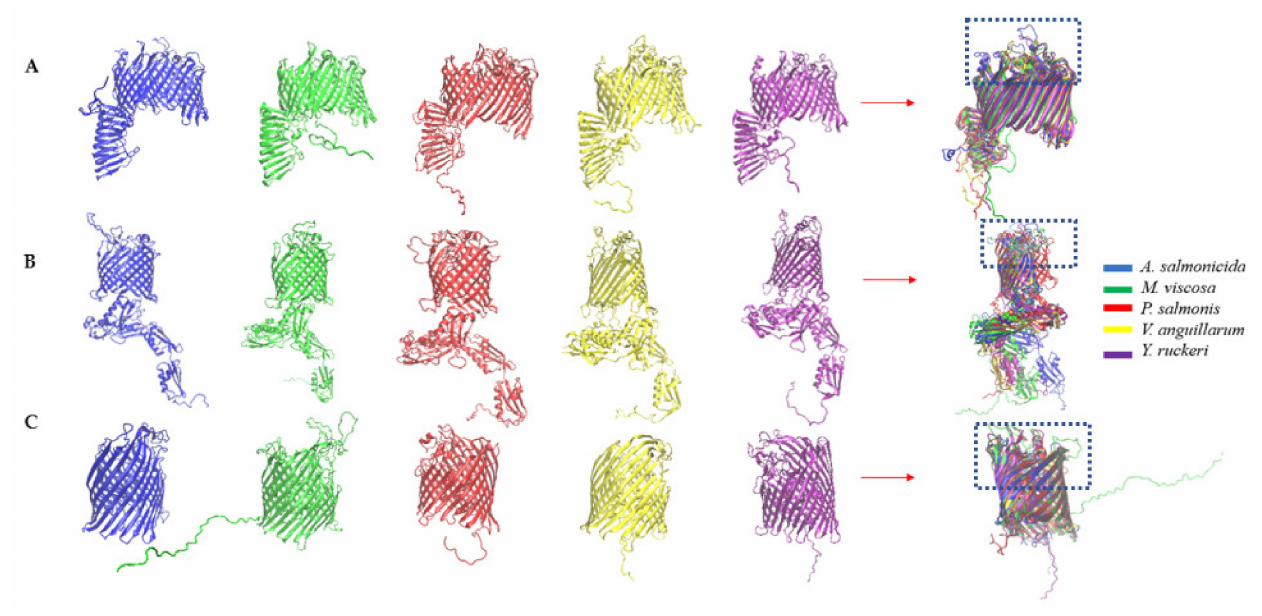
Figure 4. Three-dimensional secondary structures of common Outer membrane antigens showing structural homology for bacterial pathogens used in this study. ( A ) LPS-assembly protein LptD; ( B ) outer membrane protein assembly factor BamA protein; ( C ) TonB-dependent siderophore receptor. The regions of conserved domains are highlighted in the boxes (see Table S5 for a complete list of the conserved regions highlighted).